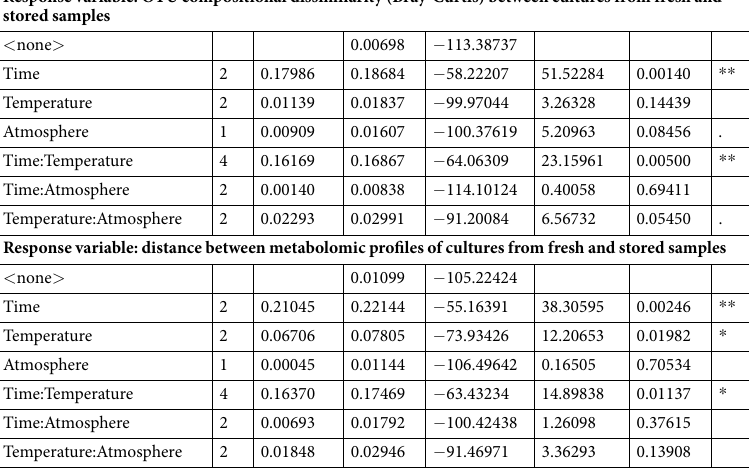
Table 2. Results of the two-way ANOVA. Impact of short-term storage conditions on culturability of raw samples. Signif. codes: 0 ‘ *** ’ 0.001 ‘ ** ’ 0.01 ‘ * ’ 0.05 ‘.’ 0.1 ‘ ’